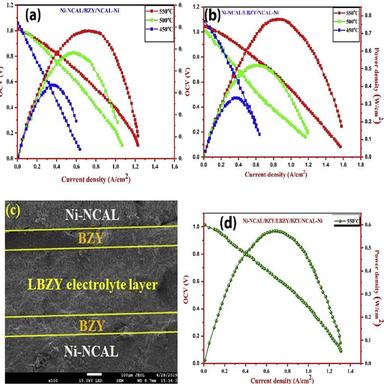
(a) Fuel cell performance of BZY and (b) La-doped BZY electrolyte at different temperatures 450e550 C while (c) illustrate the cross-sectional view of 5-layer cell and (d) protonic performance of La-BZY electrolyte at 550 C.